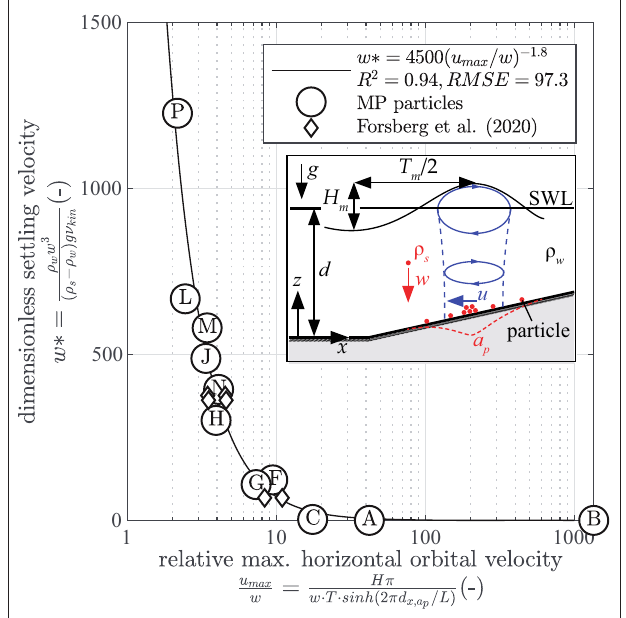
FIGURE 11 | Correlation between the dimensionless settling velocity w (red) and the relative max horizontal orbital velocity u (blue).